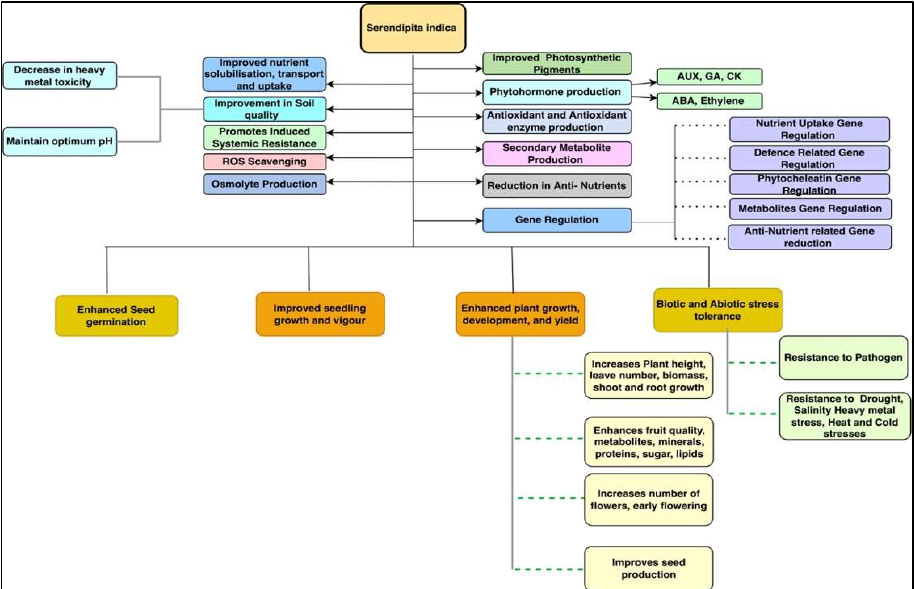
Figure 4. Schematic representation of the effects of S. indica on plant growth, development, and response to various stresses.